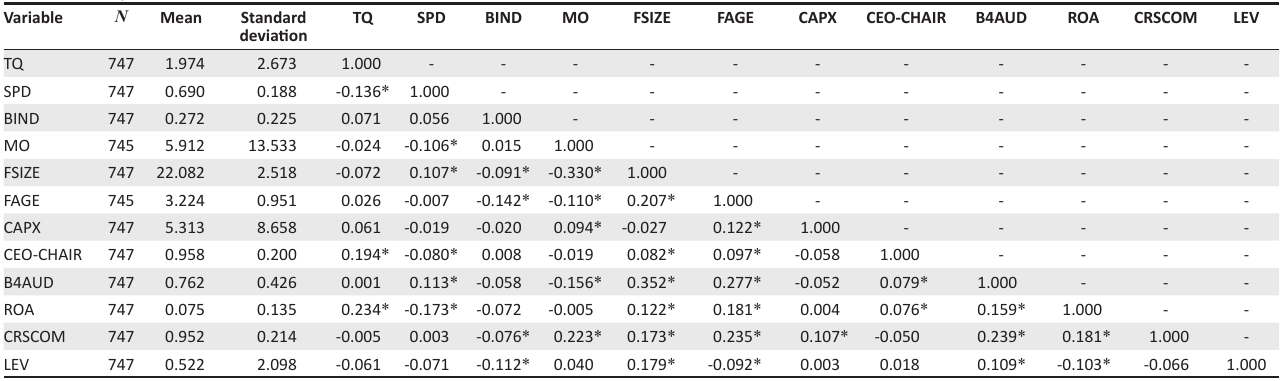
TABLE 2: Descriptive statistics and correlation matrix.